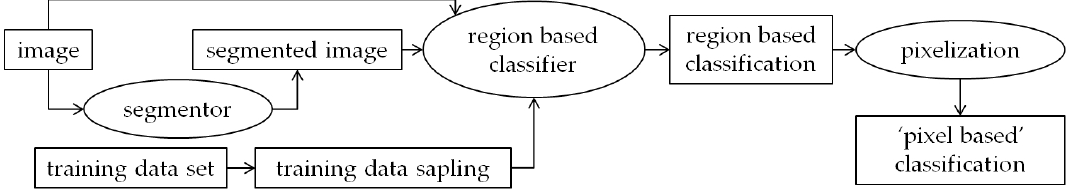
Figure 6. Steps for one classification using the Minimum Bhattacharyya Distance